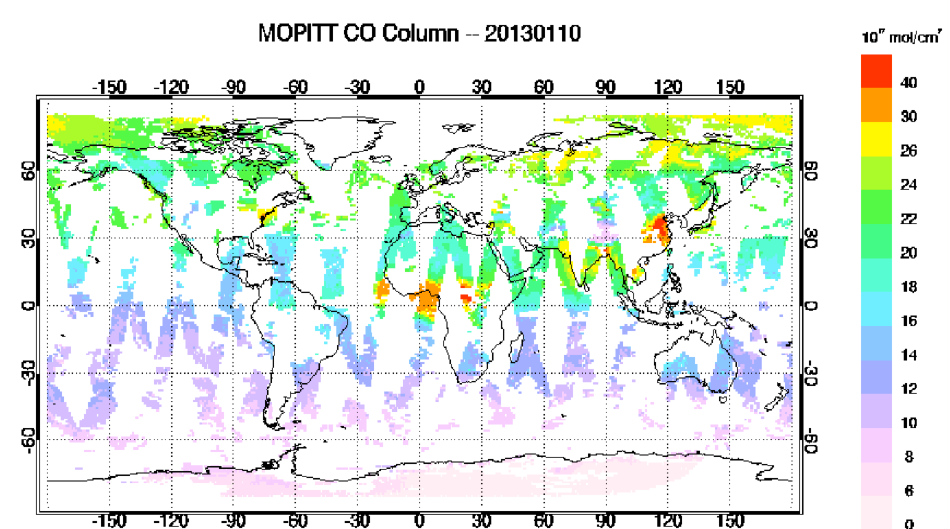
Figure 1. MOPITT CO column observations (in 10 17 molecules/cm 2 ) for Jan 10,